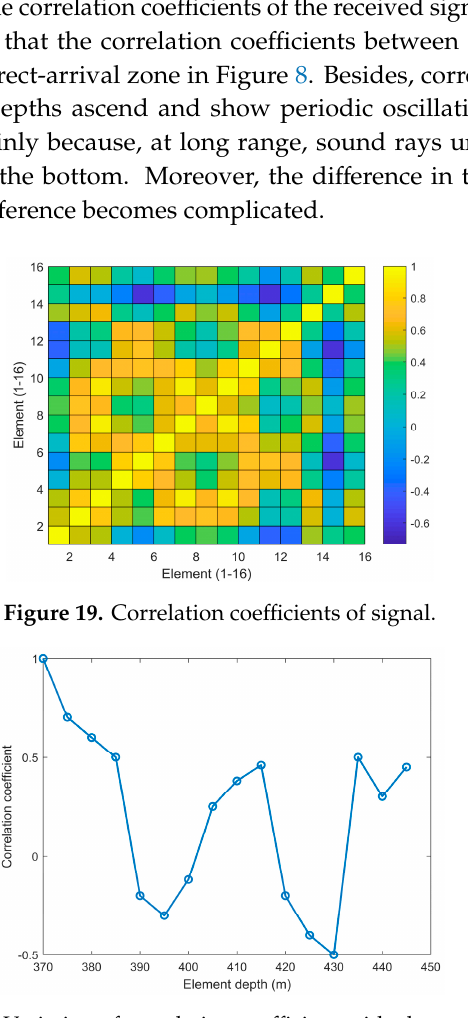
ffi cient with element Figure 20. Variation of correlation coefficient with element depth. Figure 20. Variation of correlation coe Figure 20. Variation of correlation coefficient with element depth.